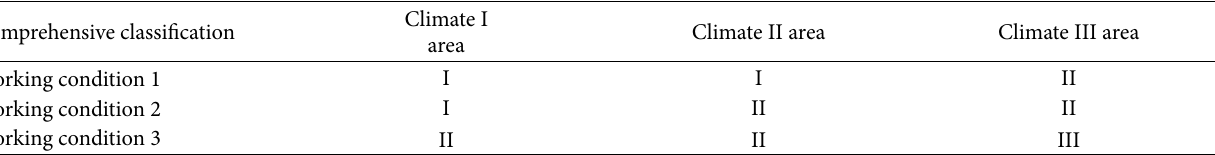
Table 9: Comprehensive classification of airport asphalt pavement